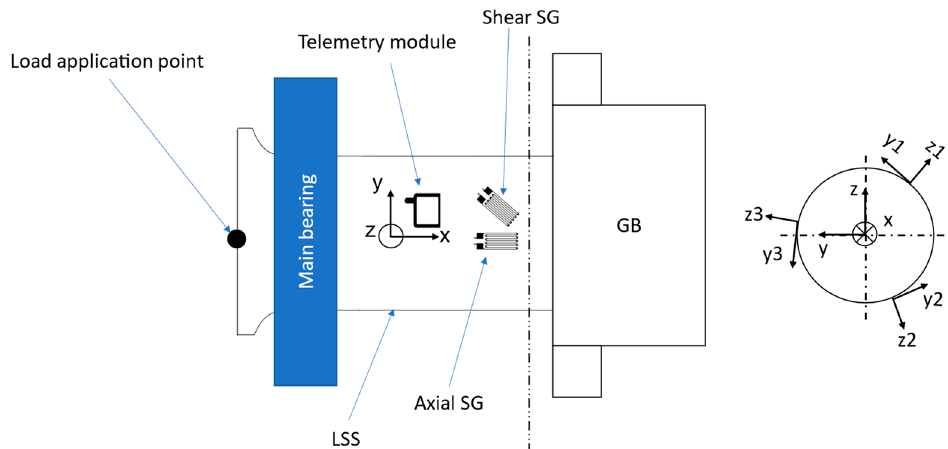
Figure 2. Illustration of LSS with load application point and the telemetry-based sensor system with SGs and their inertial COSs in the cross-section on the right.